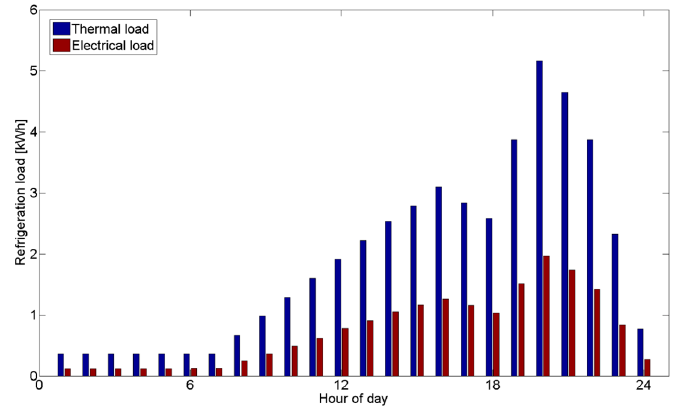
Figure 1. Refrigeration loads of the user.